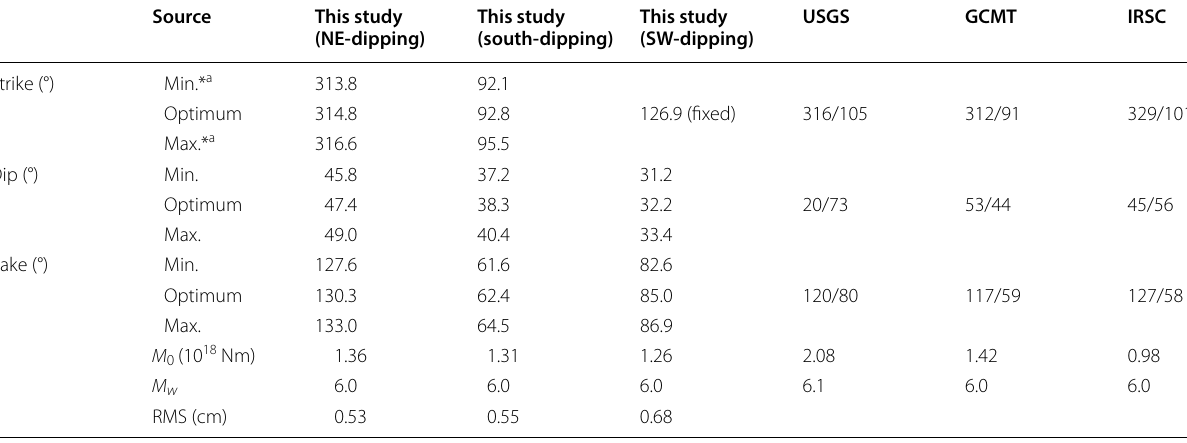
a Min. and max. denote the minimum and maximum bounds of the model confidence interval